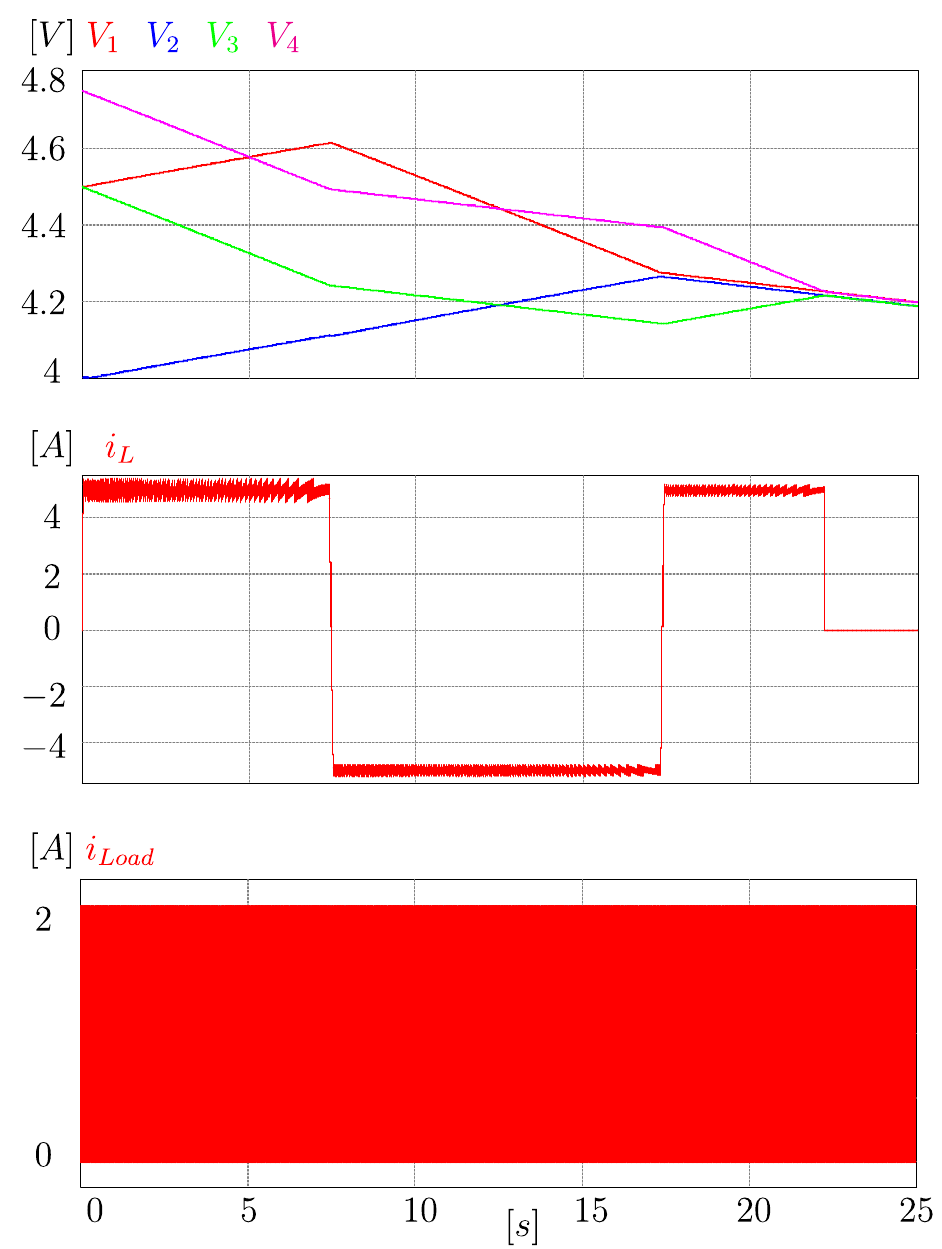
Figure 14. Simulation of the equalization process when a load is connected to the battery